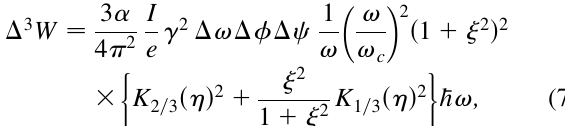
(cid:1) 3 : 6 and (cid:1) 2 (cid:1) 0 : 6 =N =N df (cid:3) X (cid:4) df (cid:3) Y (cid:4) X Y